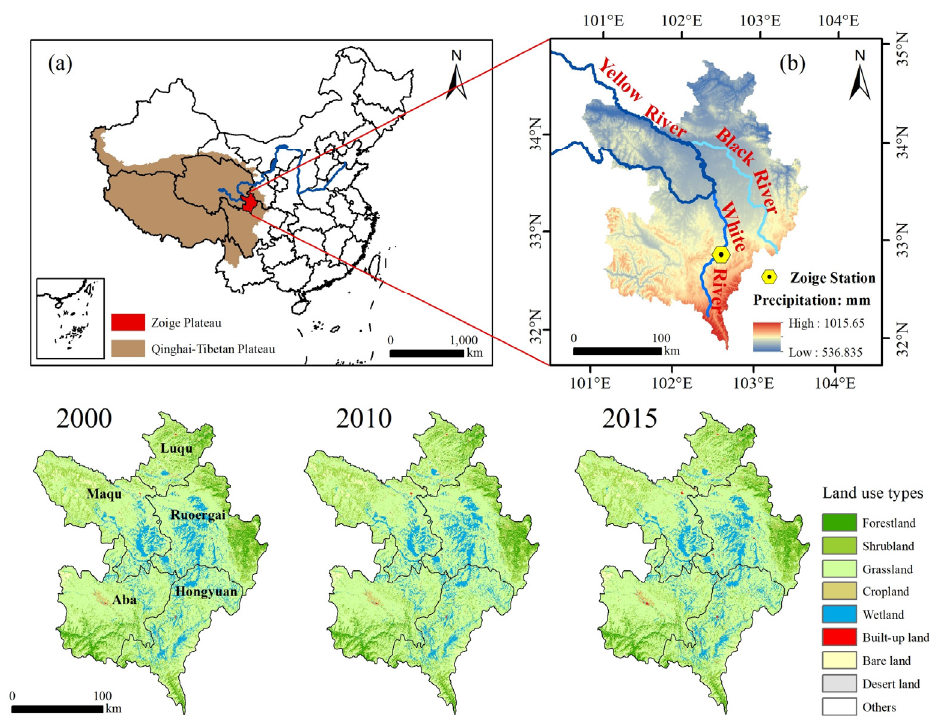
Figure 1. The location ( a ), mean annual precipitation from 1980 to 2018 ( b ), and land use type distribution from 2000 to 2015 of ZP. distribution from 2000 to 2015 of